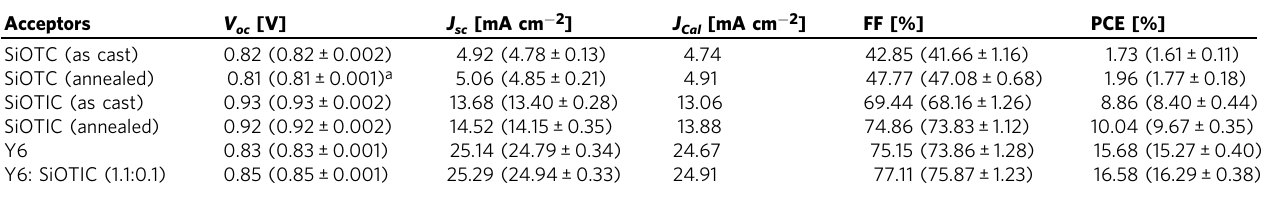
a Average value ± standard deviation were calculated from 10 independent